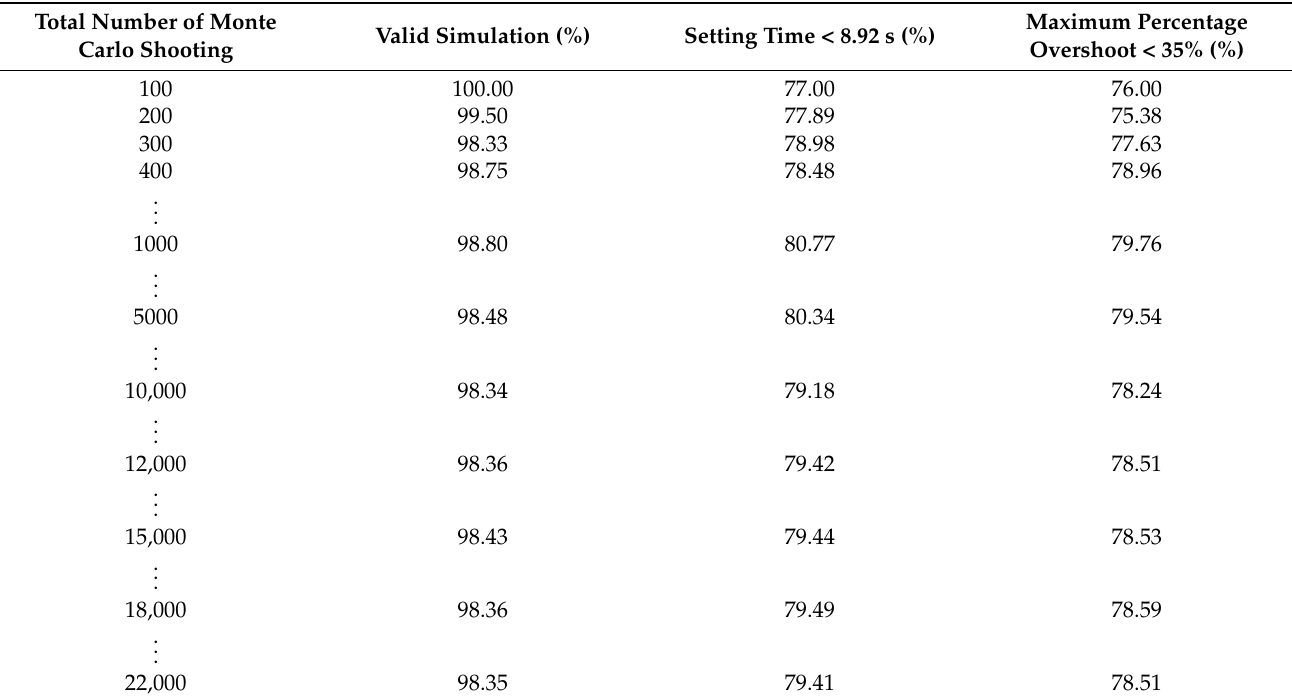
Table 2. Statistical results under different simulation